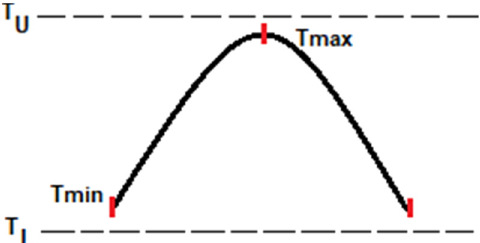
Figure 2: Simple sinus, entirely between the two thresholds ( T = upper limit, T = lower threshold, T = maximum tempera - U L max ture, T min = minimum temperature ) . Source: 27. Methodology for